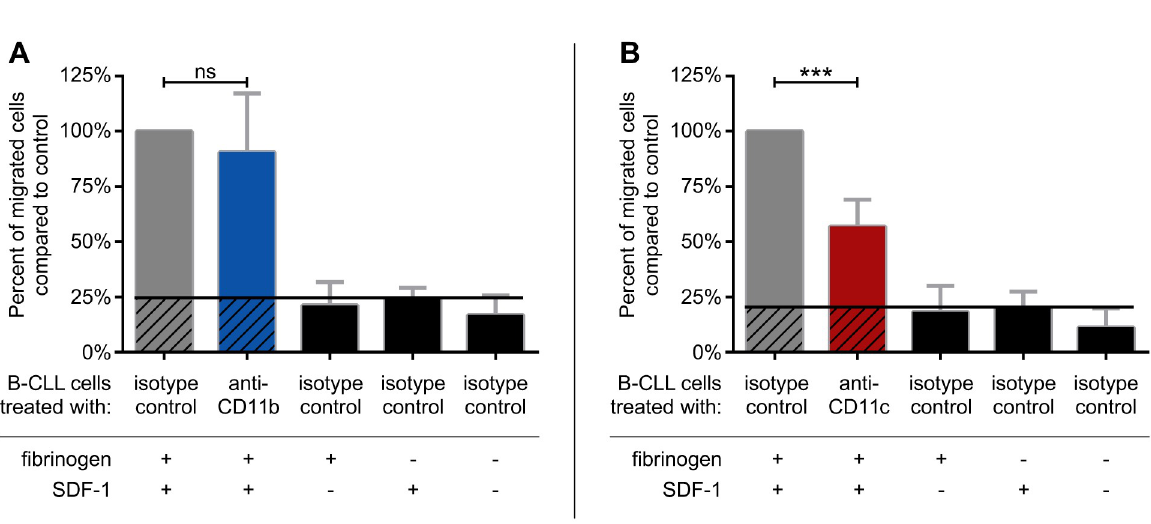
chemoattractant, which is a key contributor to CLL pathomechanism, directing the malignant cells to the bone marrow, and providing survival signal to them [26, 27]. As negative control, we performed the assay in the absence of SDF-1 and/or using a transwell membrane which was not coated with fibrinogen, only blocked with PLL-PEG.